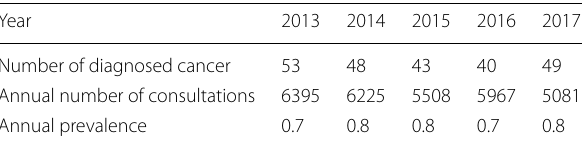
Table 1 Annual distribution of the number of diagnosed cancers, consultations and prevalence